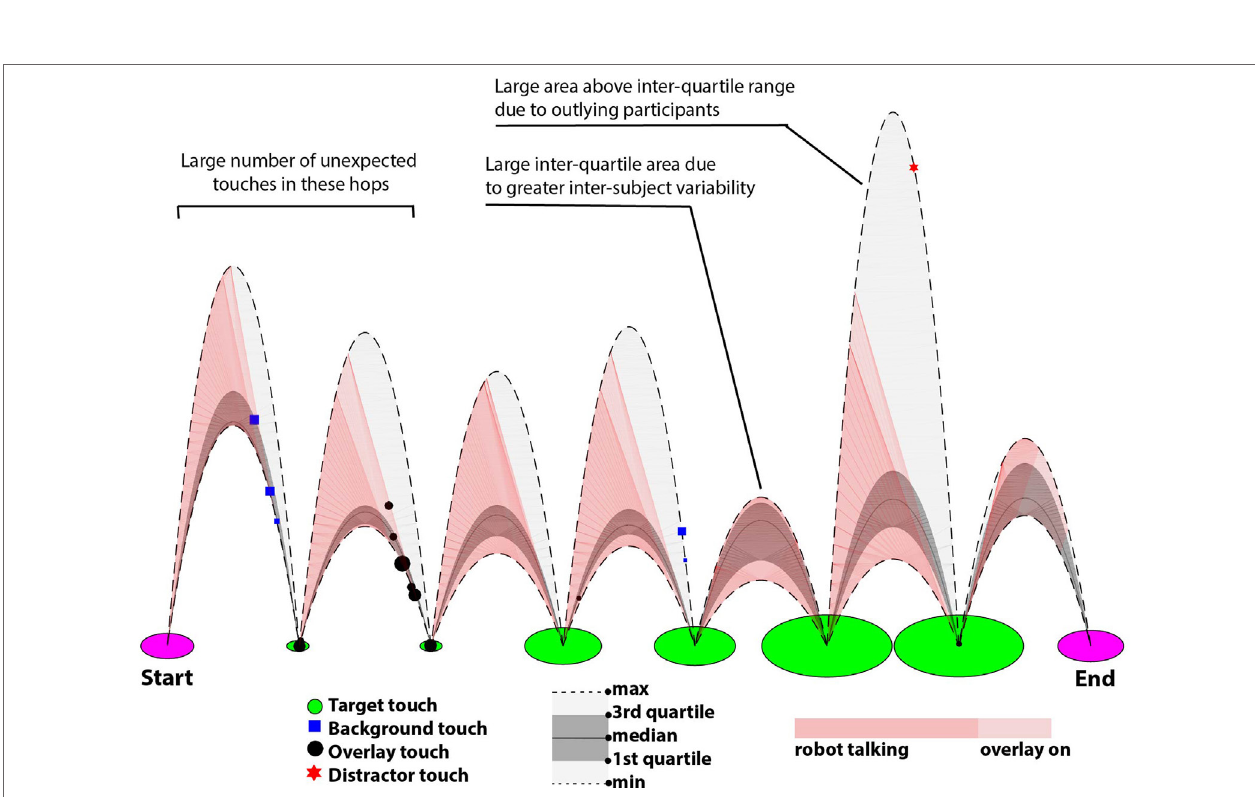
FigUre 7 | Frog-hop plot showing the timeline of the interaction of all participants with the robot. The frog-hop plot shows the study as a series of “hops”— regions bounded by parabolas that represent a single level in the storytelling game. Each green circle in between hops represents a target touch (and, therefore, the end of a level; the size of the circle is proportional to the duration of the touch). Each hop shows the accumulated touches of all the participants, where the length of the curves representing a hop is proportional to the participant’s time spent on that level (e.g., the parabola at the top of the hop shows the time taken by the slowest participant and the parabola at the bottom of the hop shows the fastest participant). The gray shaded areas represent the interquartile range of the data. The pink shaded areas represent moments when the children could not interrupt the robot, i.e., when the robot was talking or when the overlay was on. The markers in each hop represent the unexpected events: respectively, background touches (blue square), overlay touches (black circle), and non-target touches (red star). The size of the markers is proportional to the duration of the touch. The plot exhibits the variability of the behaviors observed among the participants, with a high number of unexpected events (black circles and blue squares) that would not trigger a response from the robot, particularly in the first two levels.